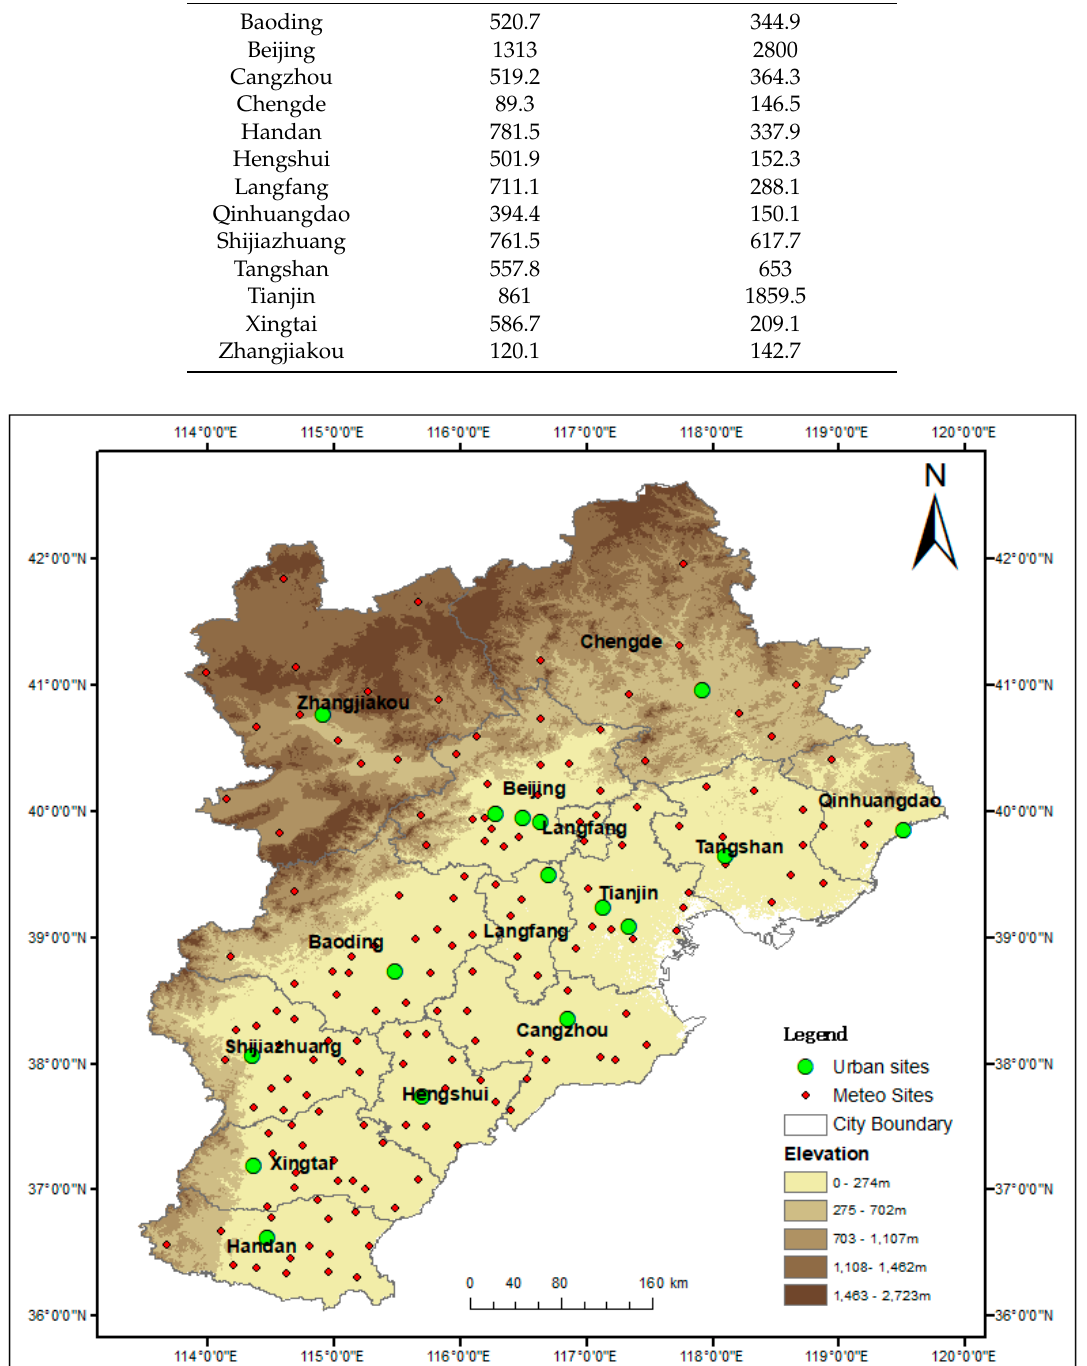
Figure 1. The distribution of meteorological sites and the terrain of the study area.